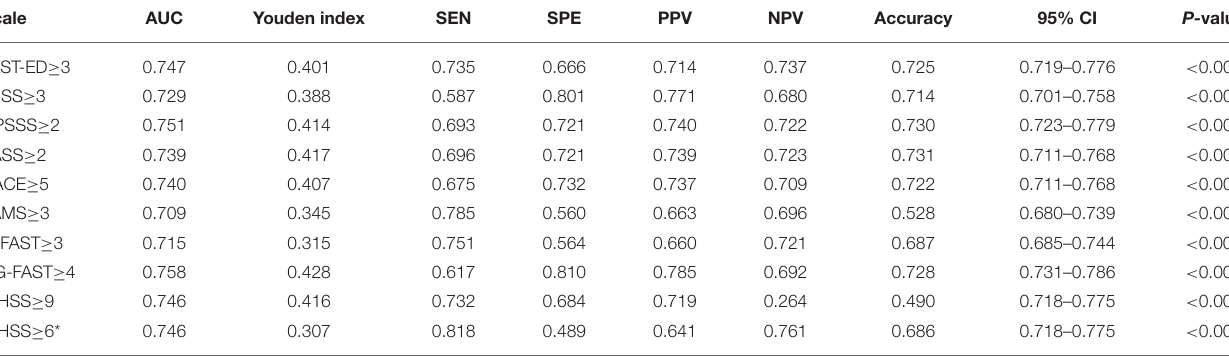
TABLE 3 | Comparison of thresholds of the pre-hospital stroke scales, CG-FAST, and NIHSS according to AUC, sensitivity, specificity, PPV and NPV, and accuracy. Scale FAST-ED ≥